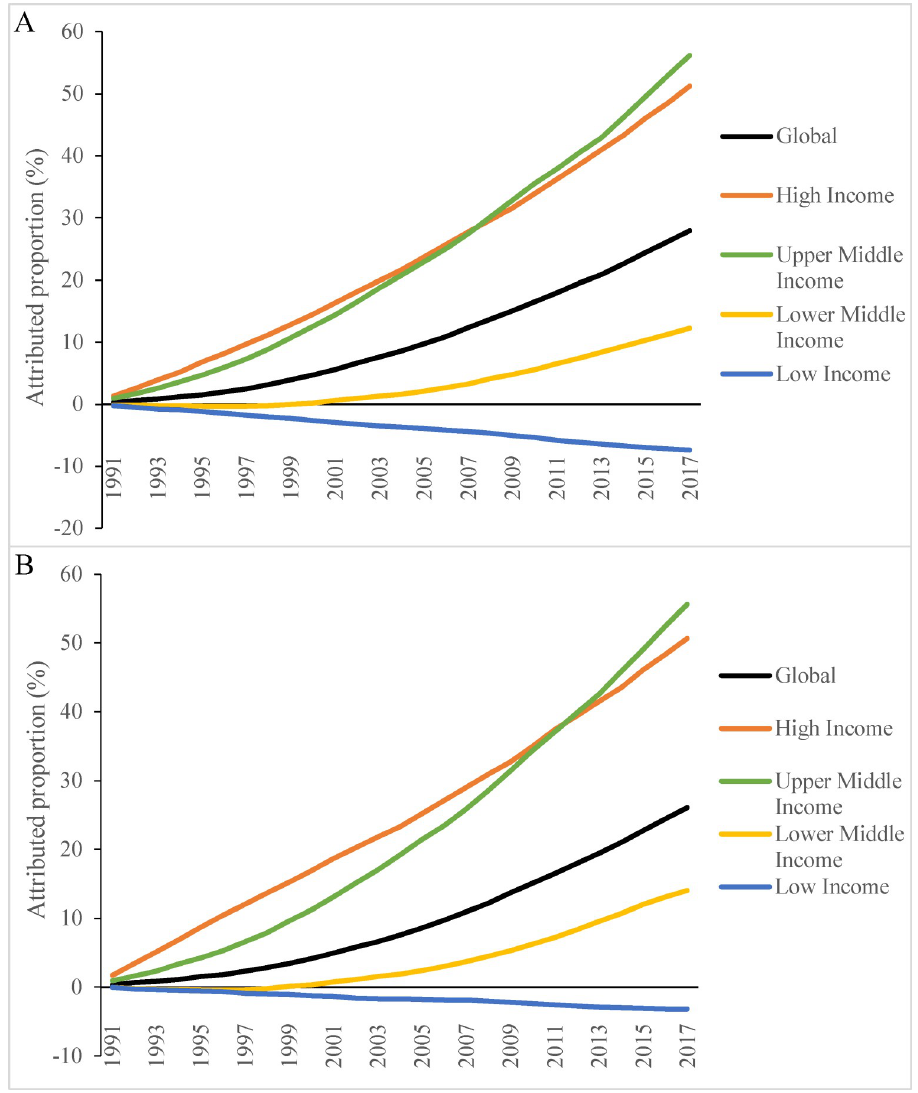
Fig 2. Proportion of deaths associated with population ageing globally and by country income category, 1990– 2017. (A) Male; (B) female. Decomposition analysis was conducted using the number of deaths in 1990 as the reference. The attributed proportion of deaths was calculated as the number of deaths attributed to population ageing divided by total deaths in 1990 × 100%. Islands (11%), and Trinidad and Tobago (11%) for females. For chronic kidney disease, only the Northern Mariana Islands (11%) had an attributed proportion greater than 10% for females. Three countries had an attributed proportion exceeding 10% for lower respiratory infections for females: Japan (12%), Singapore (11%), and Andorra (11%) (S2 Table).